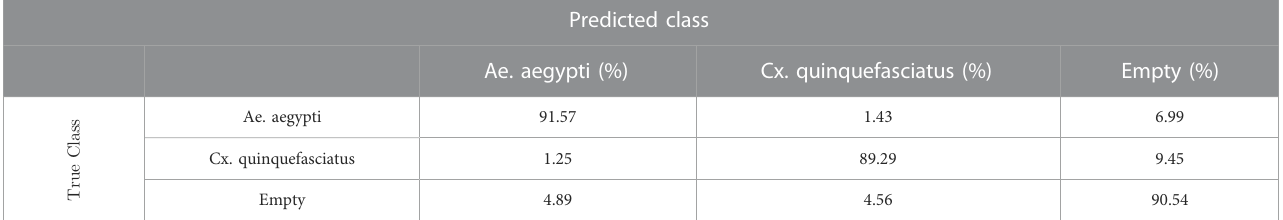
TABLE 1 Confusion matrix. A mosquito image recognition system was developed using the SqueezeNet neural network, and transfer learning was applied using the mosquito datasets, which were generated by fi xing a mosquito specimen on an insect pin and rotating it 360 ° along the Z -axis, while the camera rotated along the X -axis. LED brightness was adjusted to simulate mosquitoes under different sunlight and other light source conditions. The training database contained images of mosquitoes of different species, sexes, and ages as well as images with different brightness levels and taken at different angles. Through the live mosquito dynamic image capturing device, pictures of mosquitoes in fl ight and in other positions were taken, increasing the diversity of the training